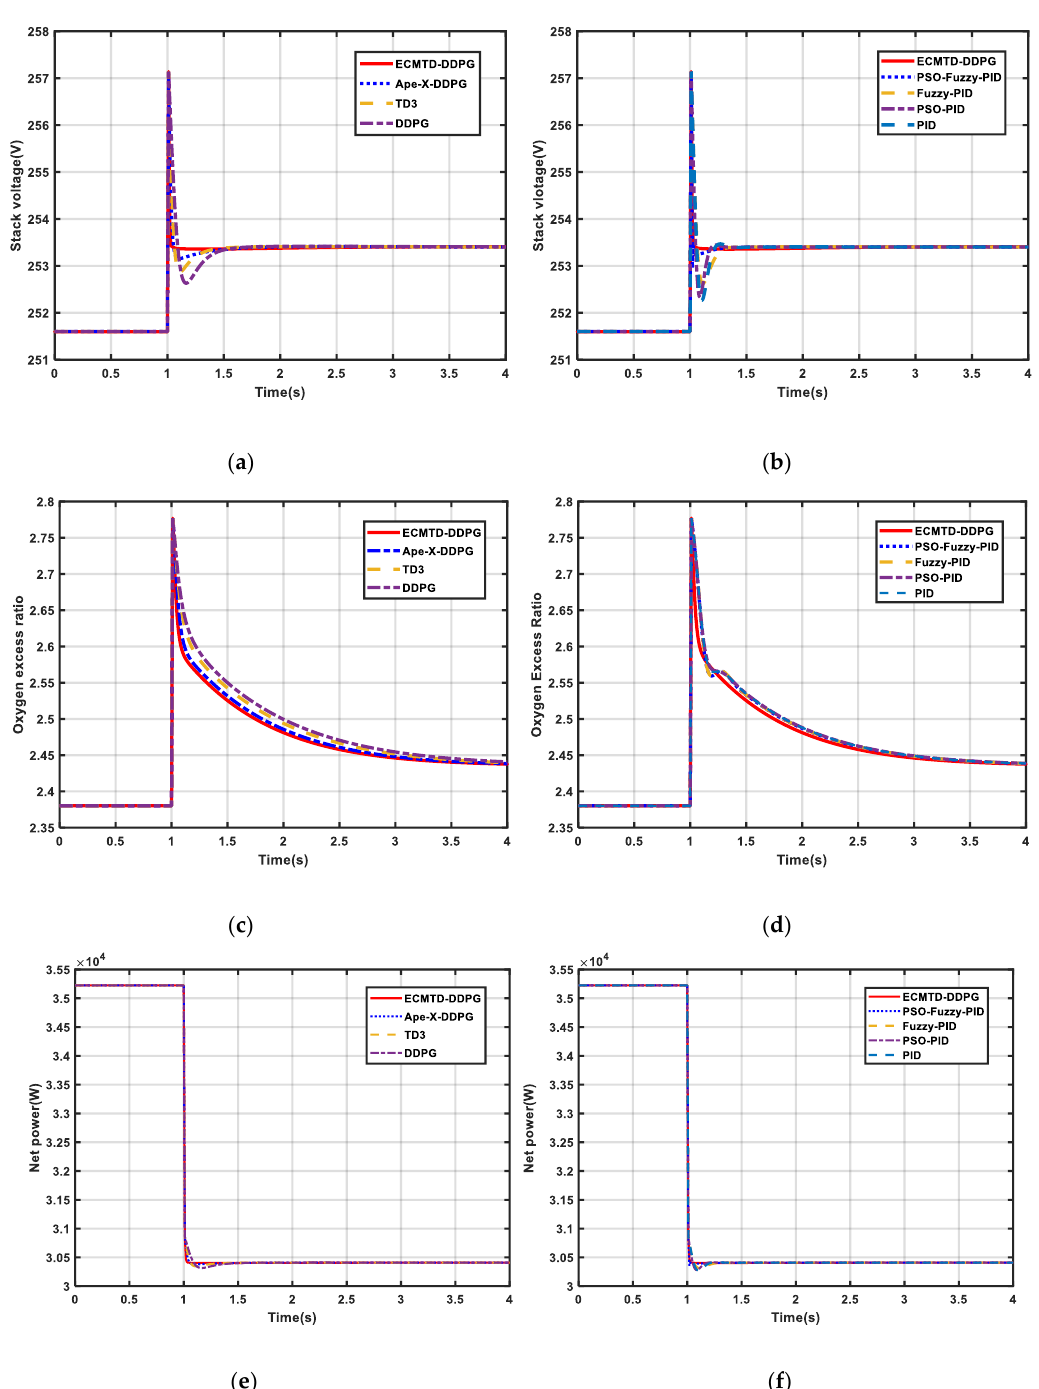
Figure 7. Result of PEMFC under step load condition ( a ) Stack voltage of PEMFC by RL algorithm ( b ) Stack voltage of PEMFC by conventional algorithm ( c ) OER of PEMFC by RL algorithm ( d ) OER of PEMFC by conventional algorithm ( e ) Net power of PEMFC by RL algorithm ( f ) Net power of PEMFC by conventional algorithm.